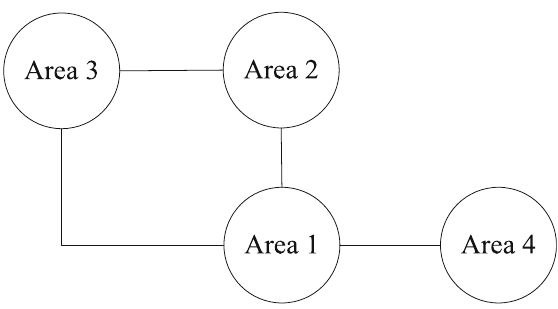
Fig. 25 Simplified diagram of a four-area power system